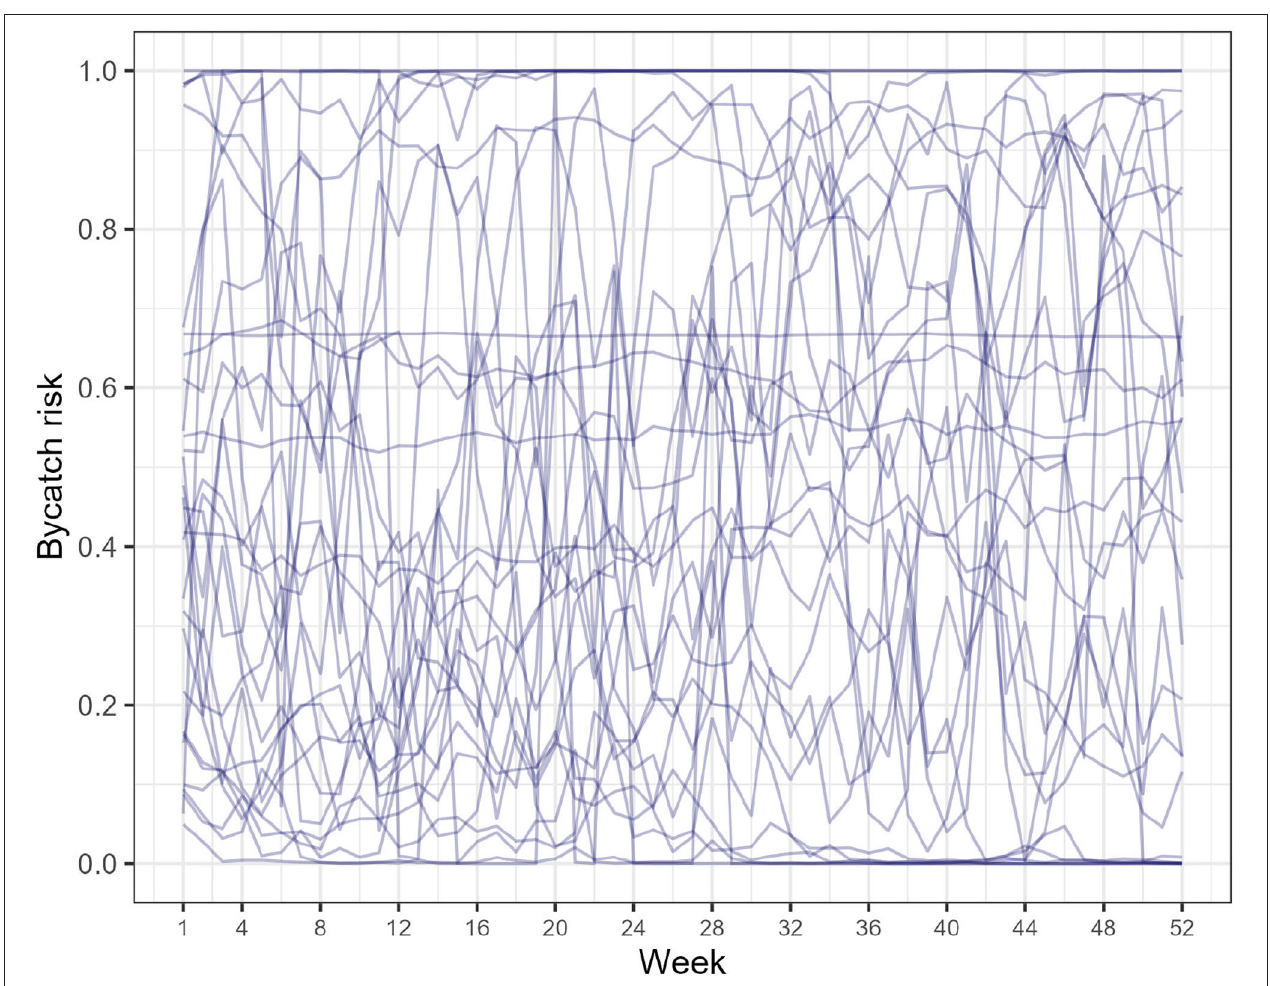
FIGURE 2 | Prior predictive checks sensu (Gabry et al., 2019). Bycatch risk ( p ijkl in Equation 1) is depicted: 30 random realizations from the priors are depicted. ICES WGBYC usually works on bycatch rates (in number of